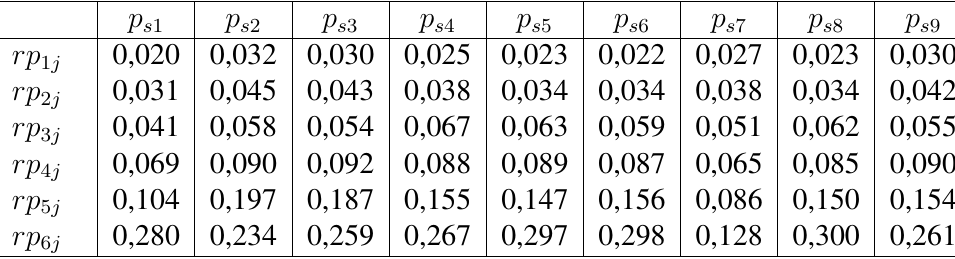
Table 4: Local priorities p